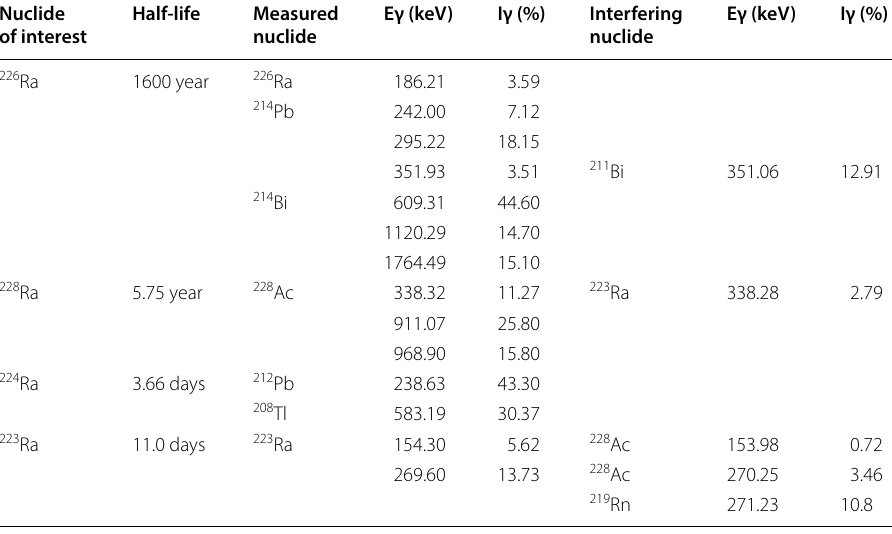
Table 1 Nuclides employed for the determination of Ra activities in the Bruchsal brine Nuclide of